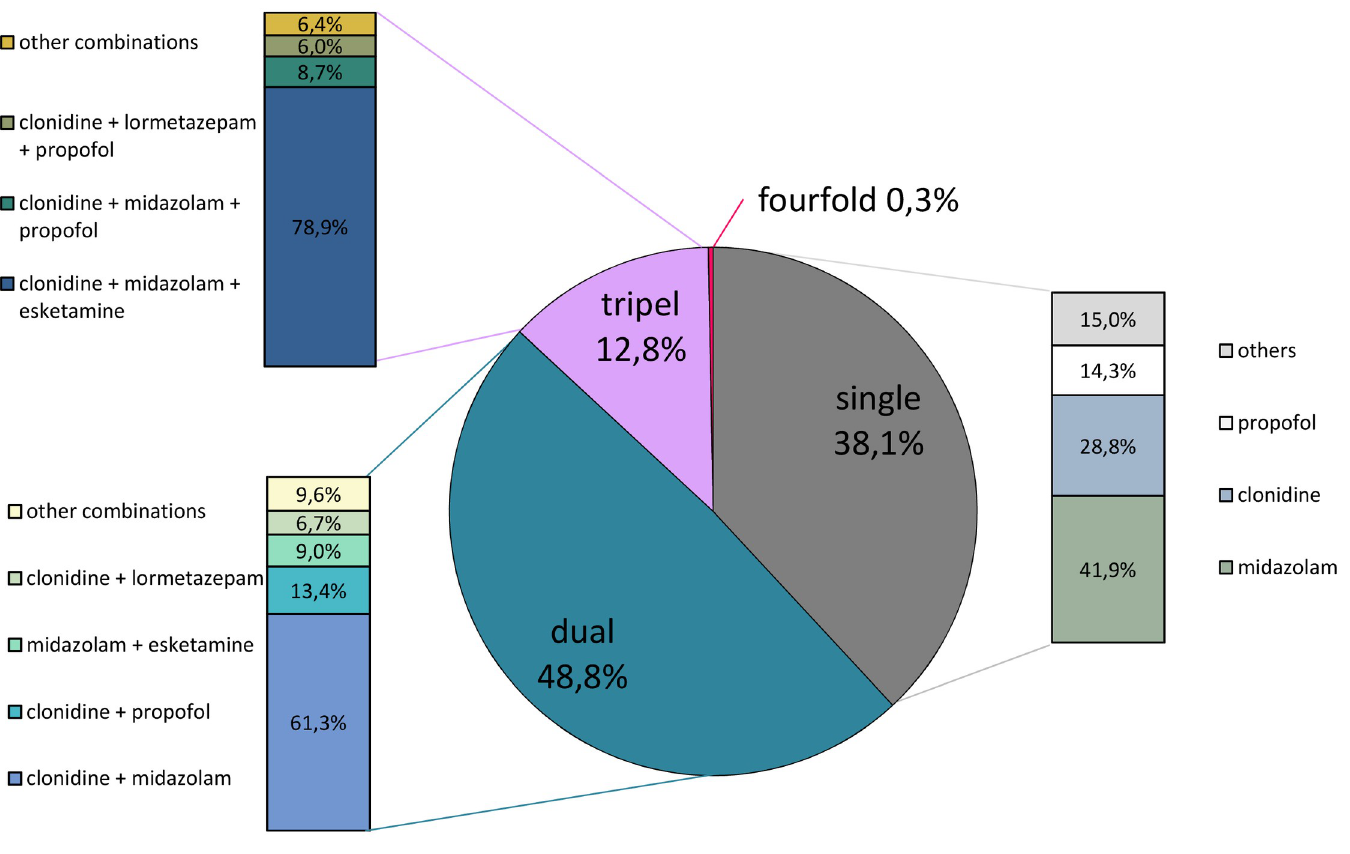
Fig 2. Single and multiple sedation in COVID-19 patients. The pie chart represents the types and frequency of single or multiple sedation in percentage. The associated bar charts represent the subdivision of the applied sedatives and their combinations in percentage. � other combinations: sum of conceivable otherwise twofold or threefold combined sedative